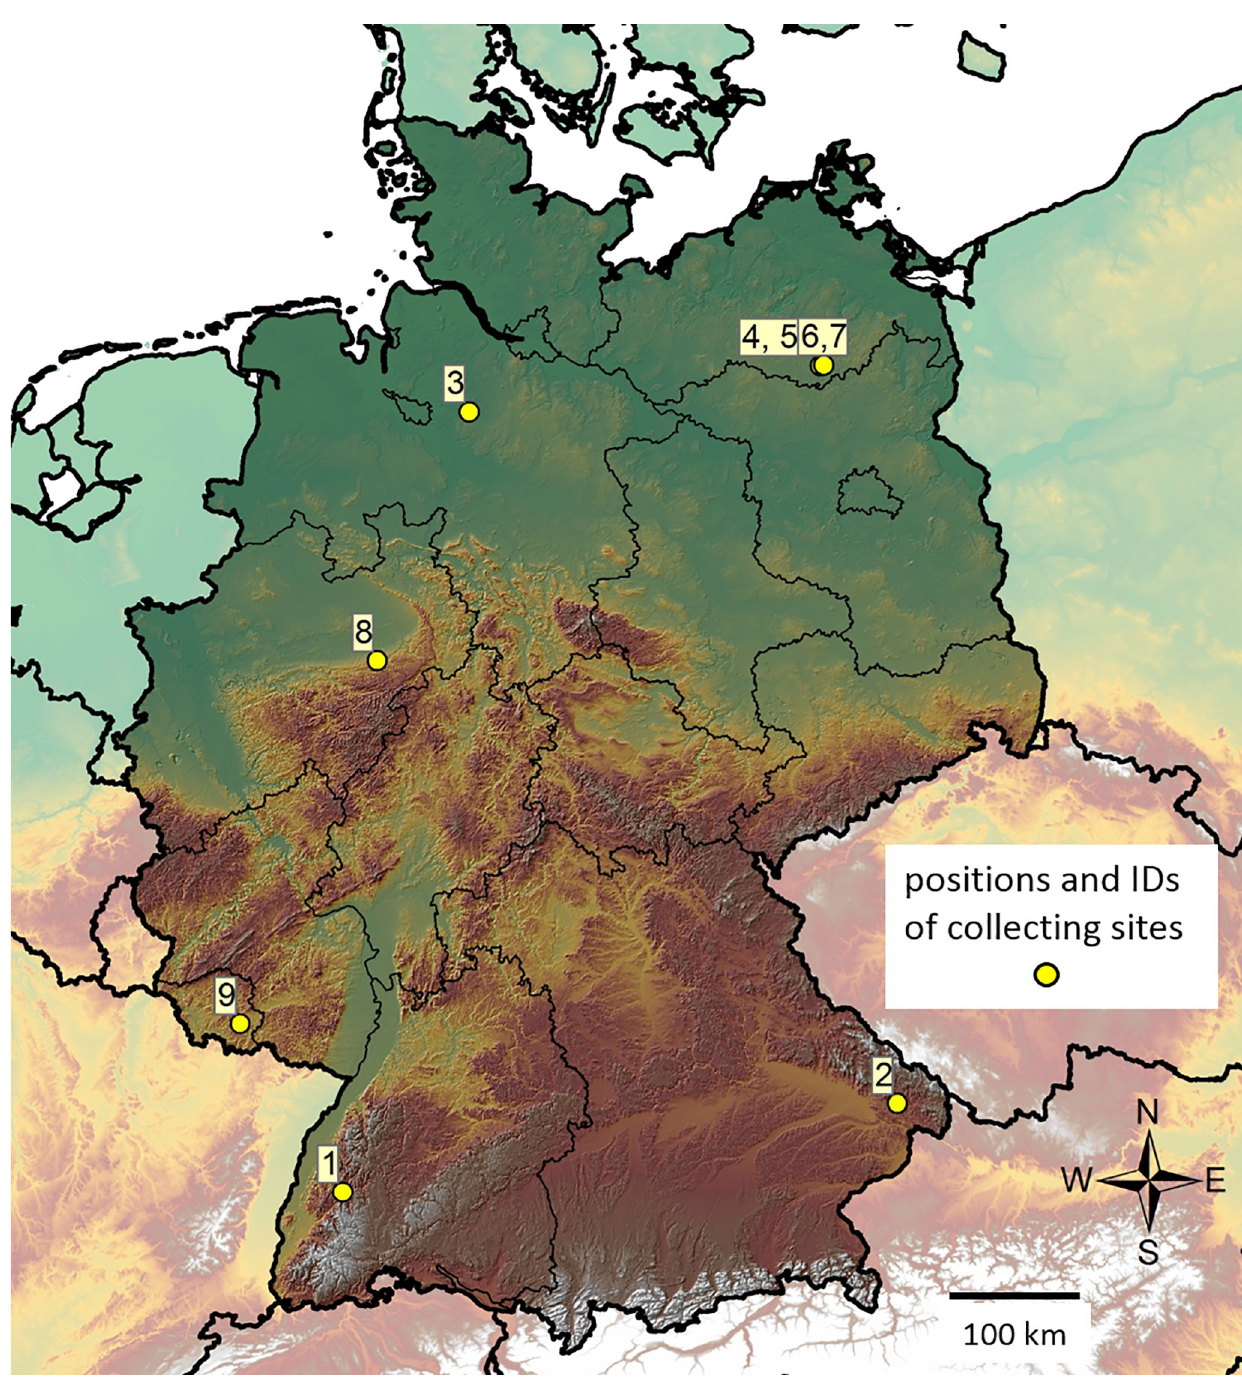
Fig 1. Map of I . ricinus collection sites in Germany. Numbers refer to sample IDs in Table 1, first column. On this scale, sites representing groups 4 and 5, and 6 and 7, respectively, are not resolved, as they are only 2.4 km apart.